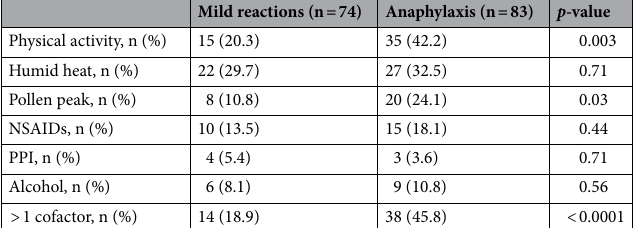
Table 2. Relationship between type of clinical presentation and